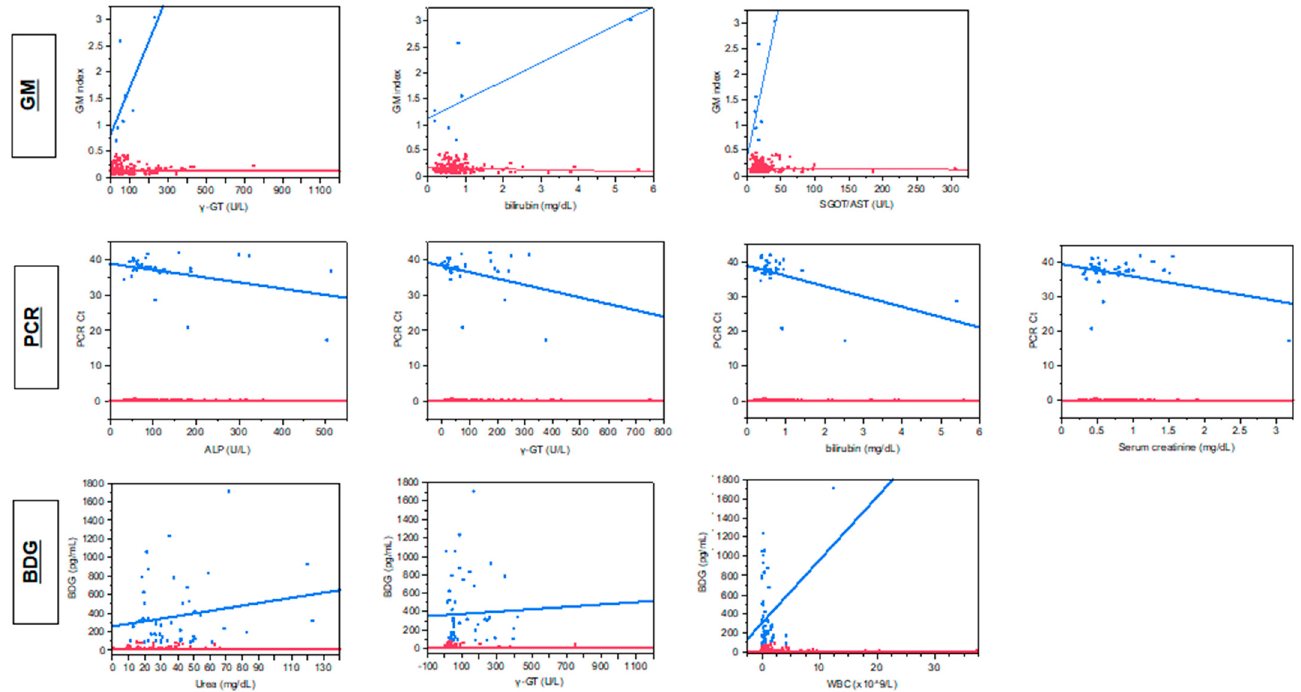
Figure 1. Correlation between fungal biomarkers [galactomannan (GM), 1,3- β -D glucan (BDG) and Aspergillus DNA (PCR] and markers of hepatic ( γ -GT, bilirubin, SGOT/AST, ALP) and renal function (serum creatinine, urea) and white blood cell counts for positive (blue lines) and negative (red lines) samples.